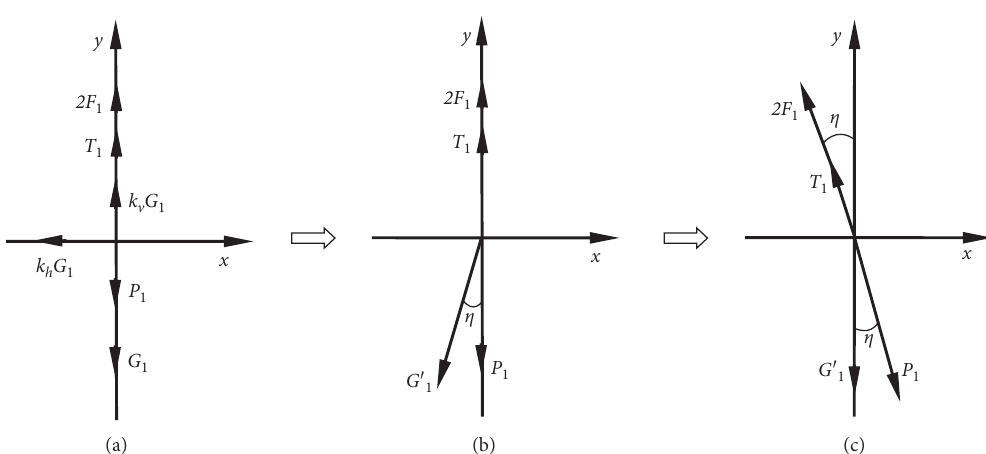
Figure 3: Calculation diagrams of the microunit. (a) Original force diagram. (b) Composition graph of inertial force and gravity. (c) Force system rotation angle η .